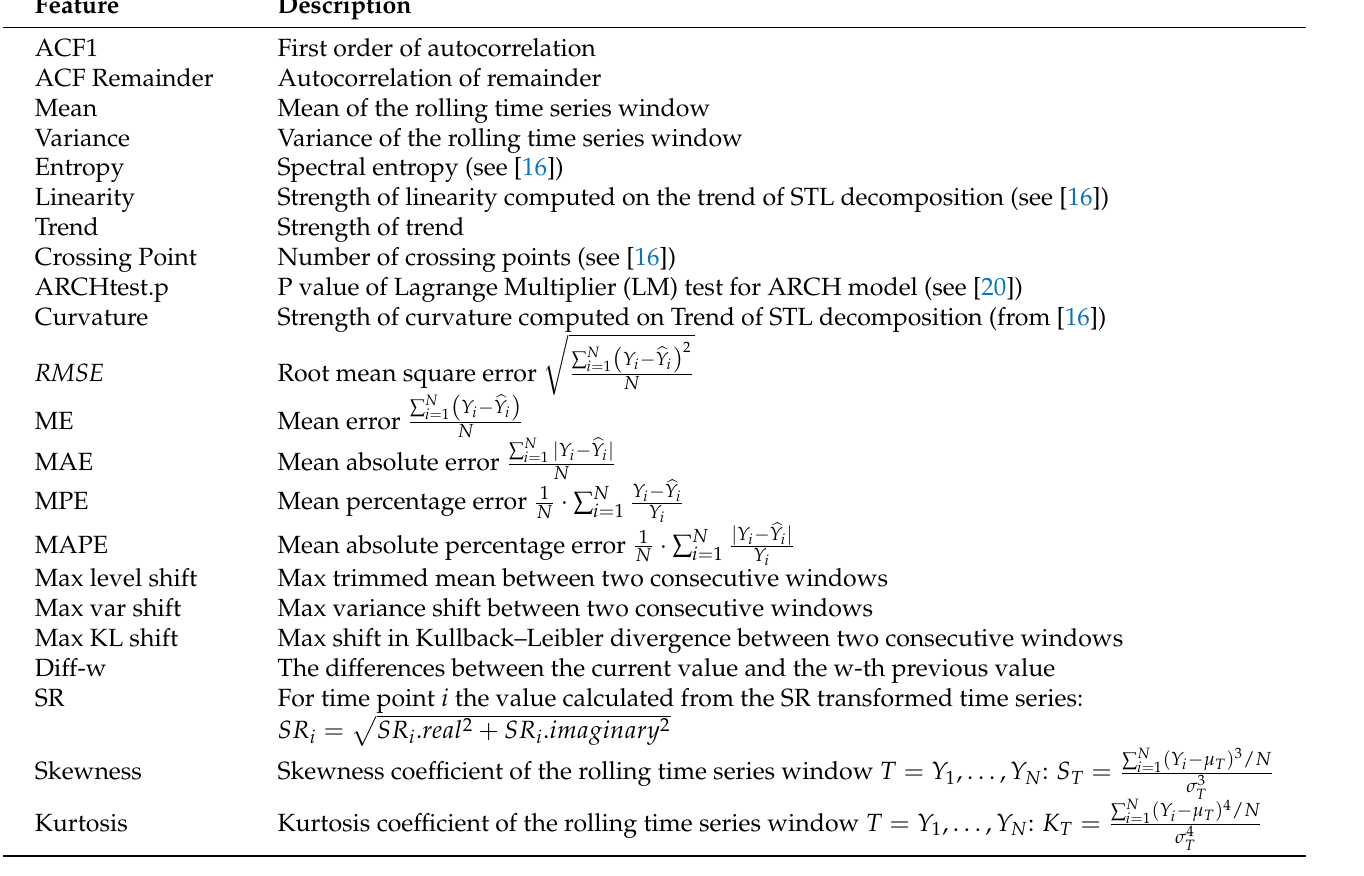
Table 1. The HAD feature set, created by adapting the feature set of [4]. Notation: N number of data points in a time series and/or set of predictions, µ T mean of values in time series T, σ T standard deviation of values in time series T, Y i the observed value at time i , (cid:98) Y i the estimated value for time